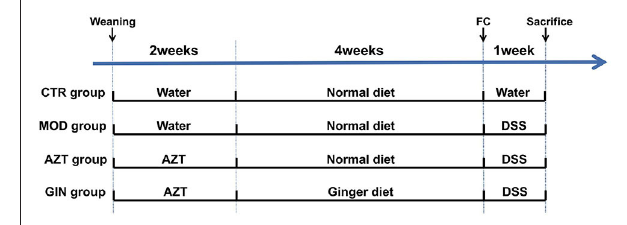
FIGURE 1 | Schematic diagram summarizing the timeline of experimental procedures. Three-week-old C57BL/6 male mice were randomly assigned to four groups ( n = 8–10): control (CTR) group; model (MOD) group; AZT group; and ginger (GIN) group. FC, fecal collection.